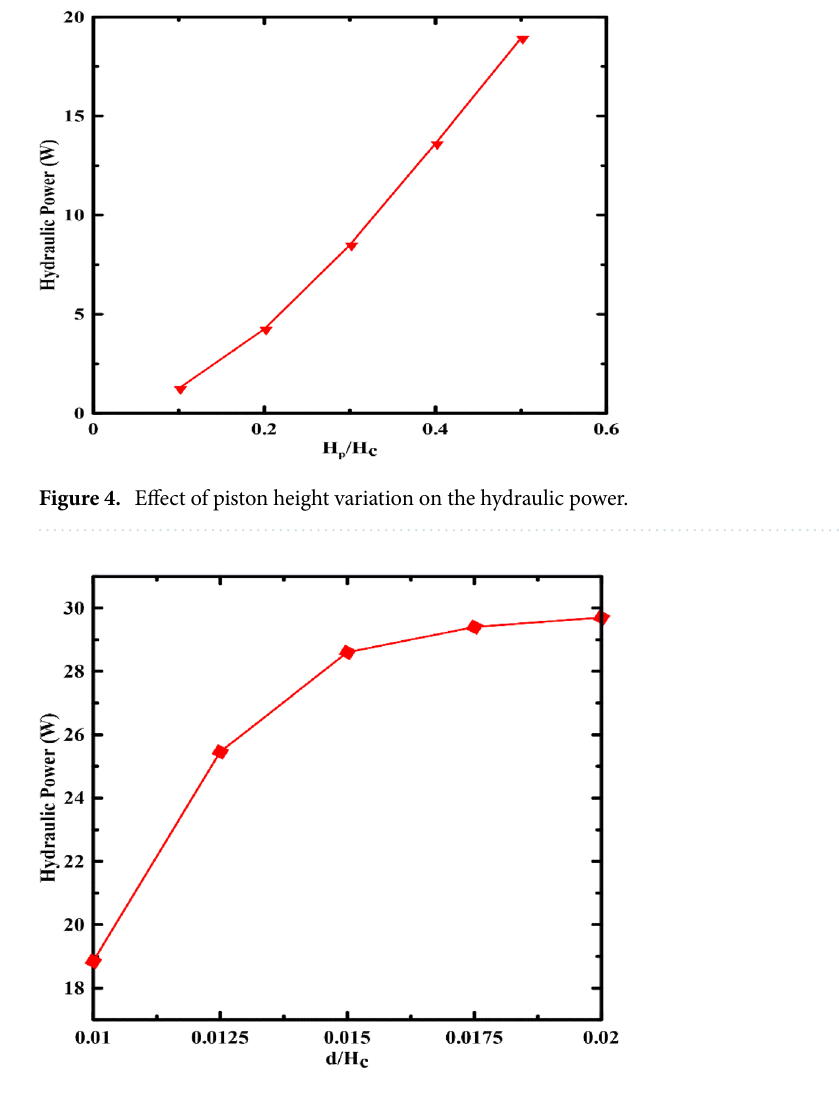
Figure 5. Effect of return pipe diameter variation on the system’s power.